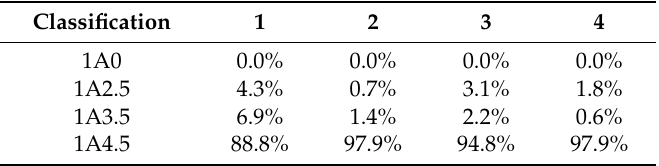
Table 9. Recognition results of the tracking and erosion resistance of samples classified as 1A 4.5 using the LIBS technique based on the neural network